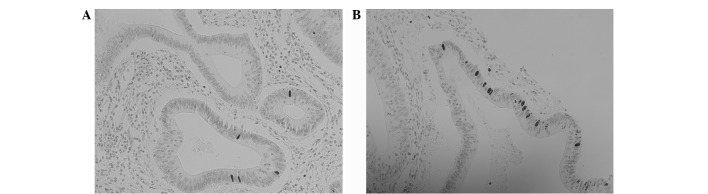
Immunohistochemical staining of CD133 expression in different TNM stages of colorectal carcinoma: TNM stages (A) I and (B) III. Magnification, ×200.